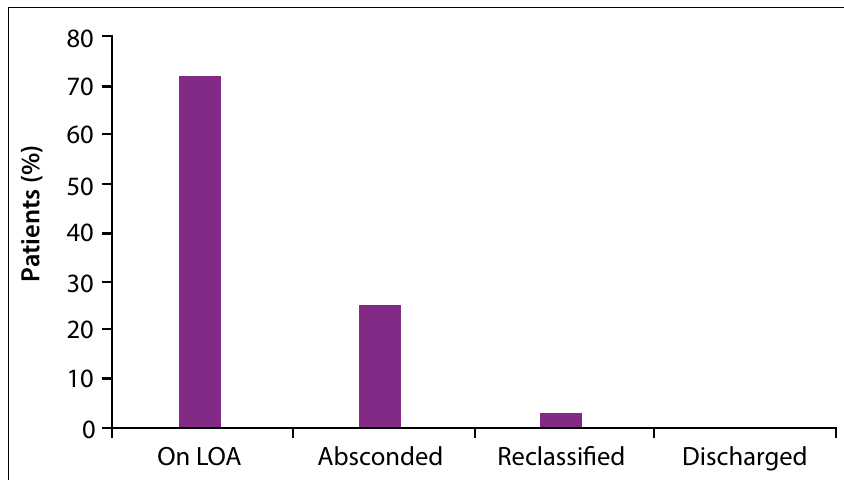
Fig. 1. Total study population, 3-year outcome.